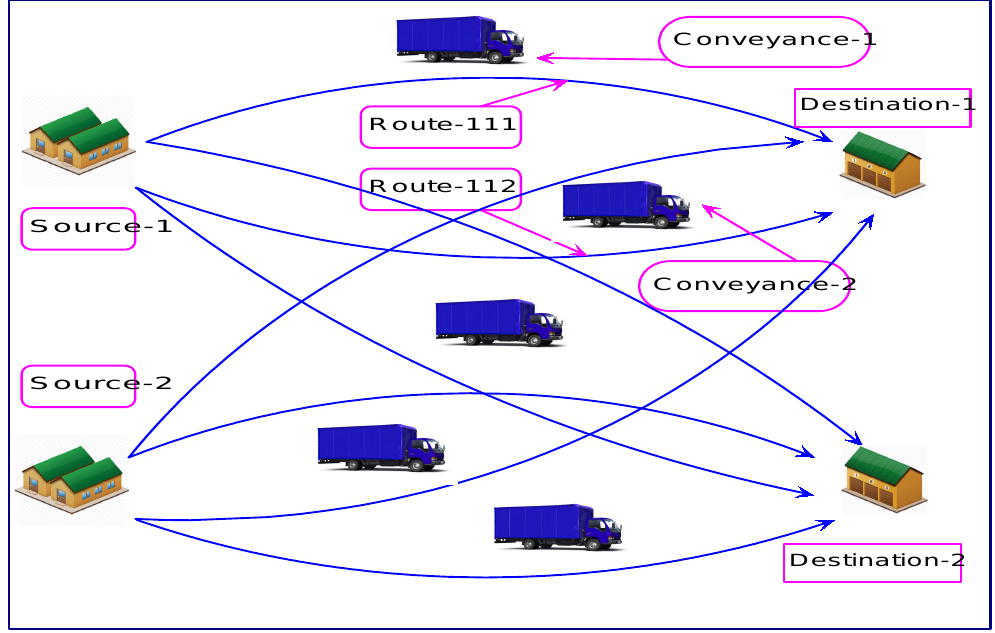
Figure 1. Pictorial representation of a four-dimensional transportation